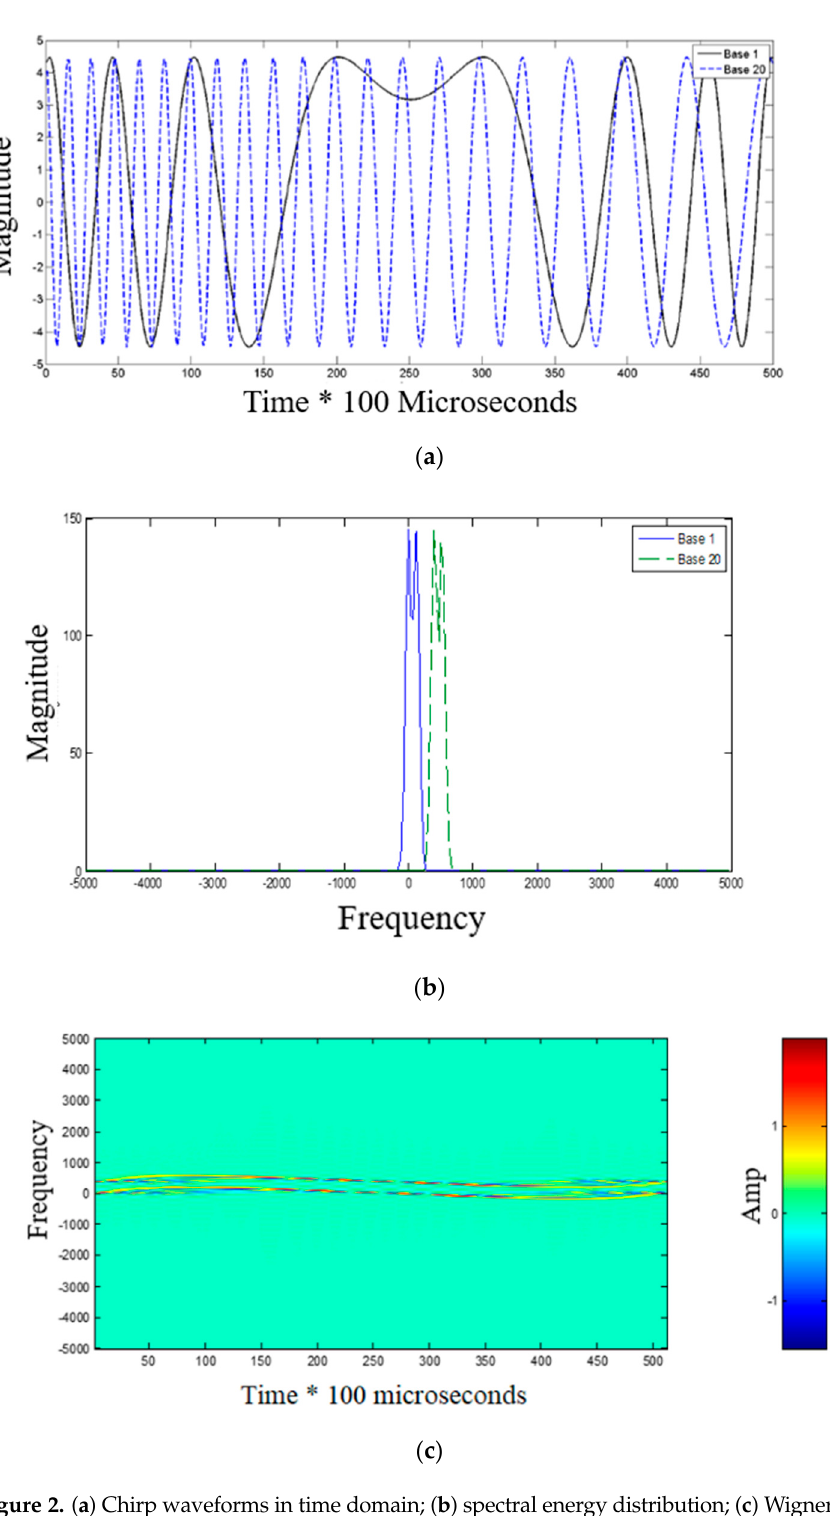
Figure 2. ( a ) Chirp waveforms in time domain; ( b ) spectral energy distribution; ( c ) Wigner distribution .